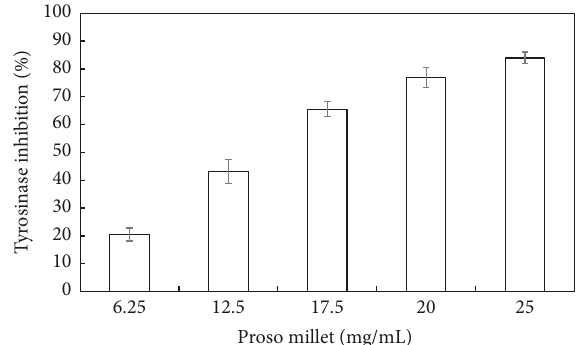
Figure 3: Effect of the proso millet extract concentration on the inhibition of tyrosinase.